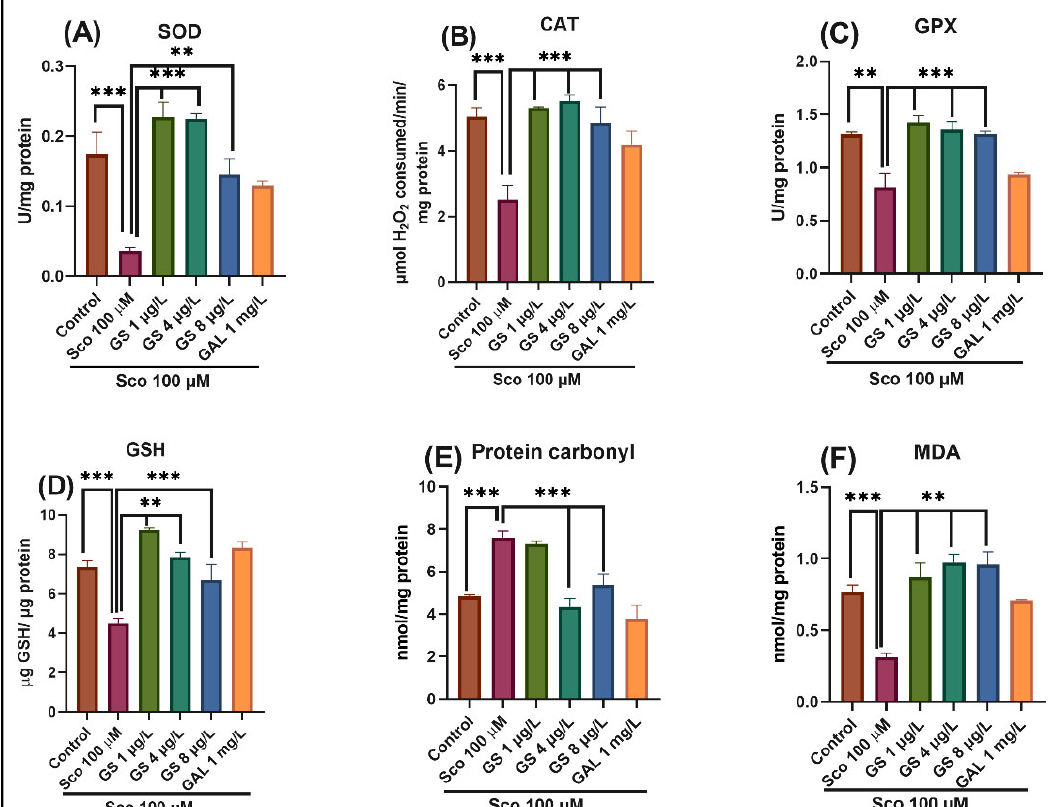
Figure 6. Guiera senegalensis hydroethanolic extract (GS: 1 μ g/L, 4 μ g/L and 8 μ g/L) improved brain antioxidant status. ( A – C ) Representation of the enzymes’ specific activity: superoxide dismutase (SOD), catalase (CAT), and glutathione peroxidase (GPX) in different groups; ( D – F ) Representation of the reduced glutathione (GSH), protein carbonyl, and malondialdehyde (MDA) levels in different groups. Values are means ± S.E.M. ( n = 10). For Tukey’s post hoc analyses: ** p < 0.001 and *** p < 0.0001.